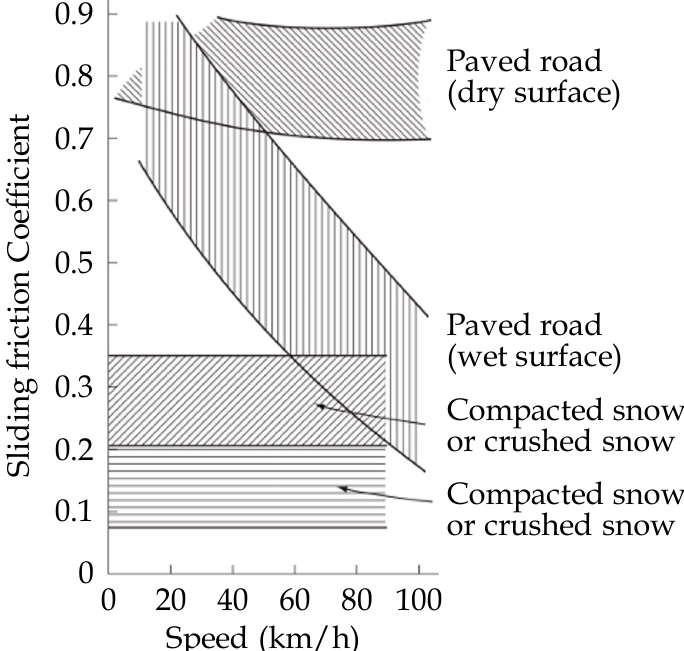
Figure 1. Sliding friction coefficient and road surface condition [1].